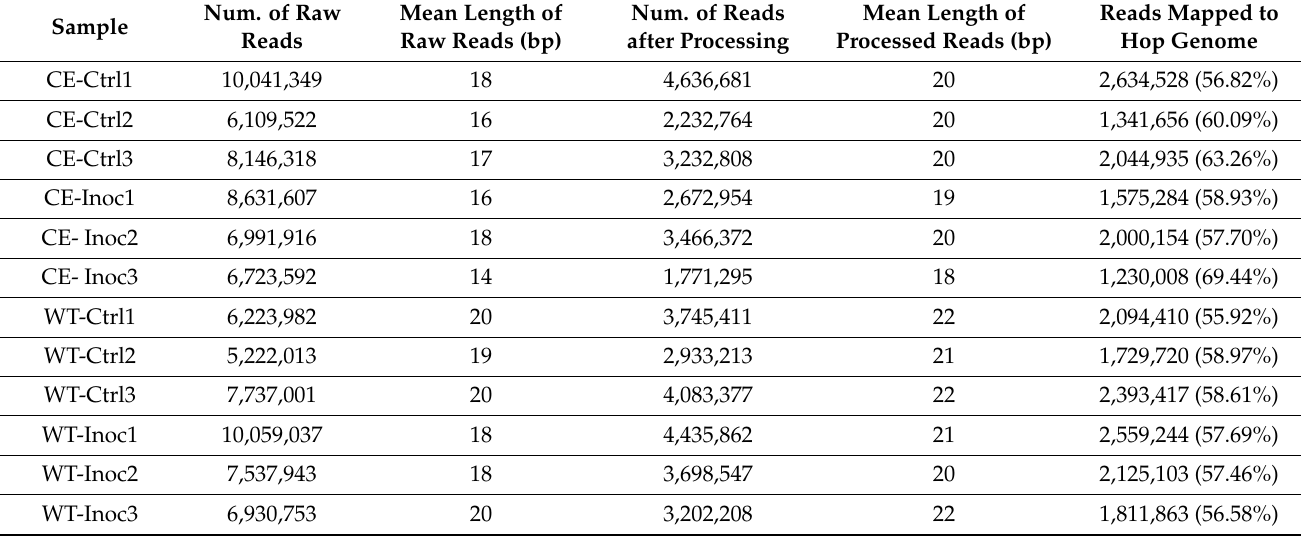
Table 1. Statistics of small RNA sequencing reads from 12 sRNA libraries. First two letters of sample names denote cultivar; CE, susceptible cultivar Celeia; WT, resistant cultivar Wye Target; Ctrl, control; Inoc, inoculated, and numbers denote biological replicates